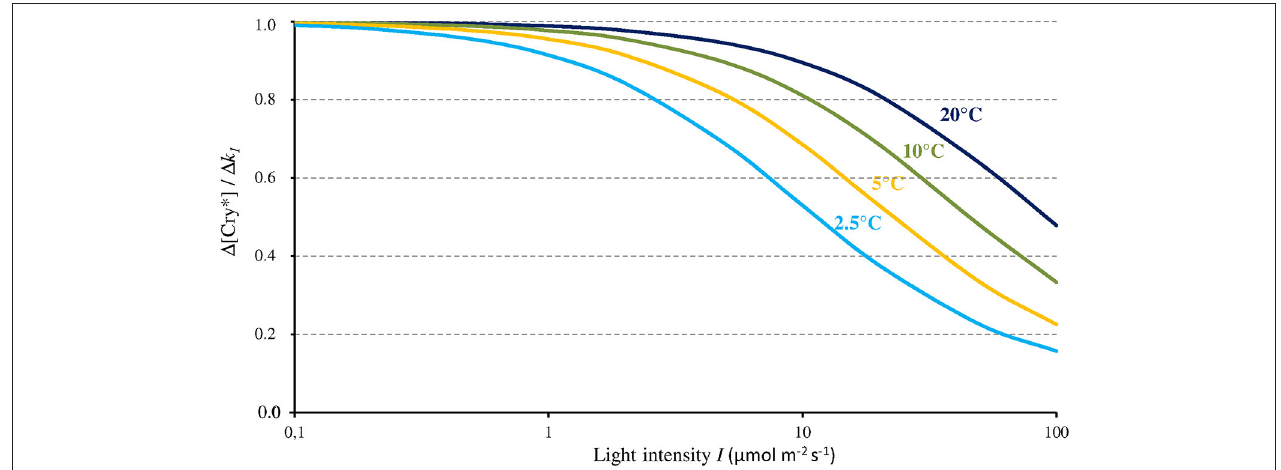
FIGURE 3 | Change of the concentration of the active form of Cry (Cry*) relative to the change of k 1 (as caused by a MF) as a function of blue light intensity ( I , 350–500nm) and for different temperatures. From that relationship, a MF can thus only express its full effect at low light intensities.